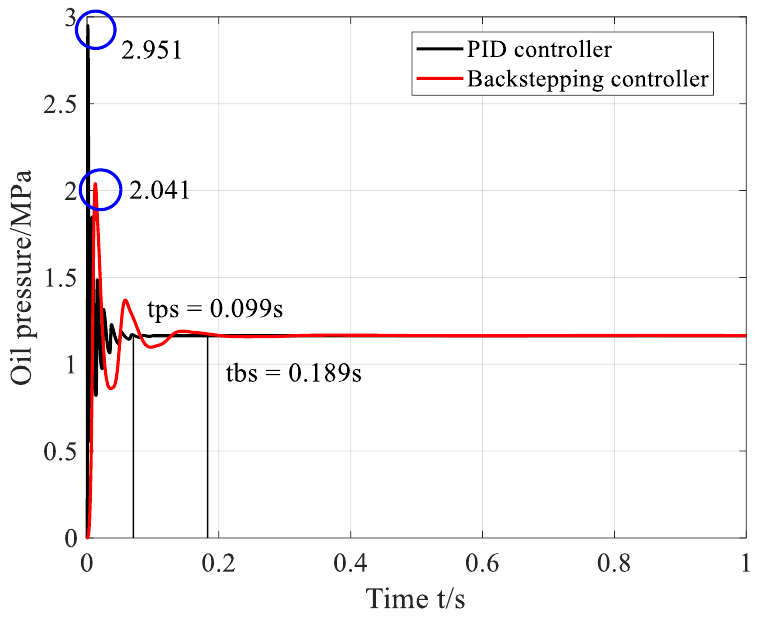
Figure 8. Comparison of following control effect between the backstepping controller and the PID controller.